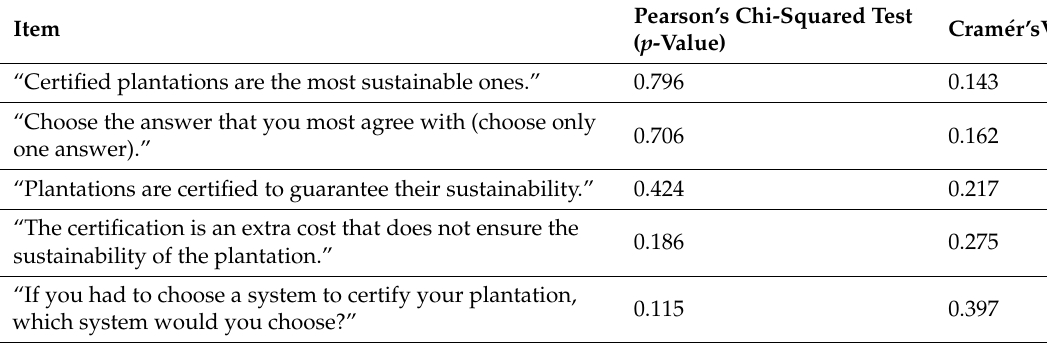
Table 3. Difference in perceptions of forest certification and sustainability among stakeholder